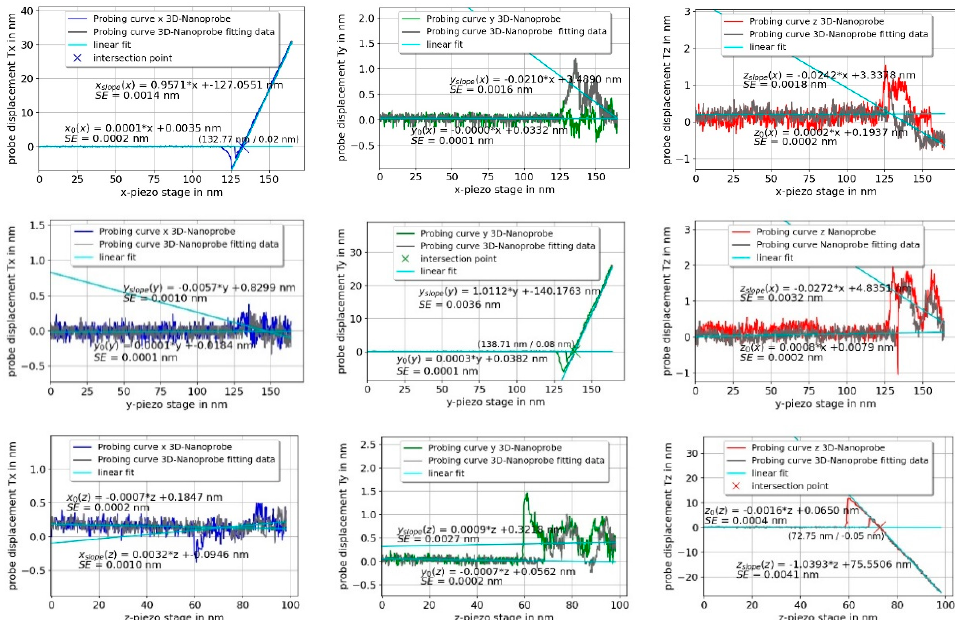
Figure 5. Full set of calibration curves for a 3D-Nanoprobe in the orthogonal x -, y -, and z -directions. Each curve shows the calibrated displacement of the probe over the displacement of the stage. Each curve is fitted by linear fits and the slopes are taken to determine the quality of the calibration. The probing curves are full interaction curves with retraction (snap-in and pull-off clearly visible, for instance, for z-probe displacement while probing in the z-direction, bottom right).